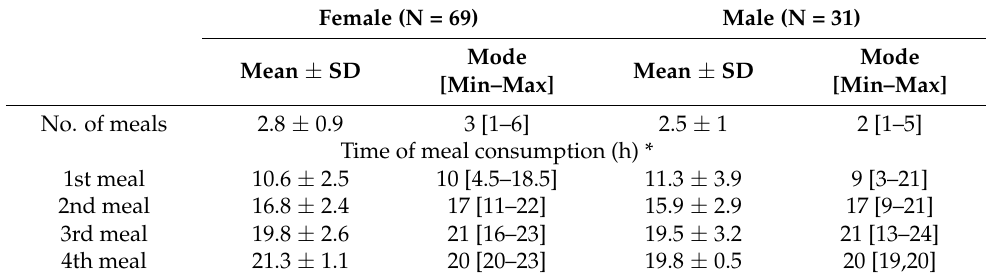
Table 4. Number of meals and their distribution during the day.